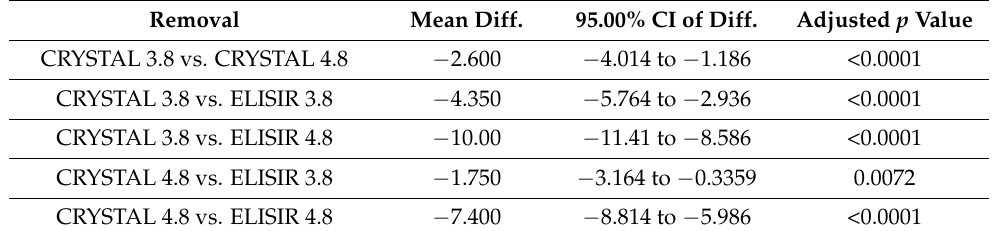
Table 4. ANOVA post-hoc of removal mean comparisons of the study groups.